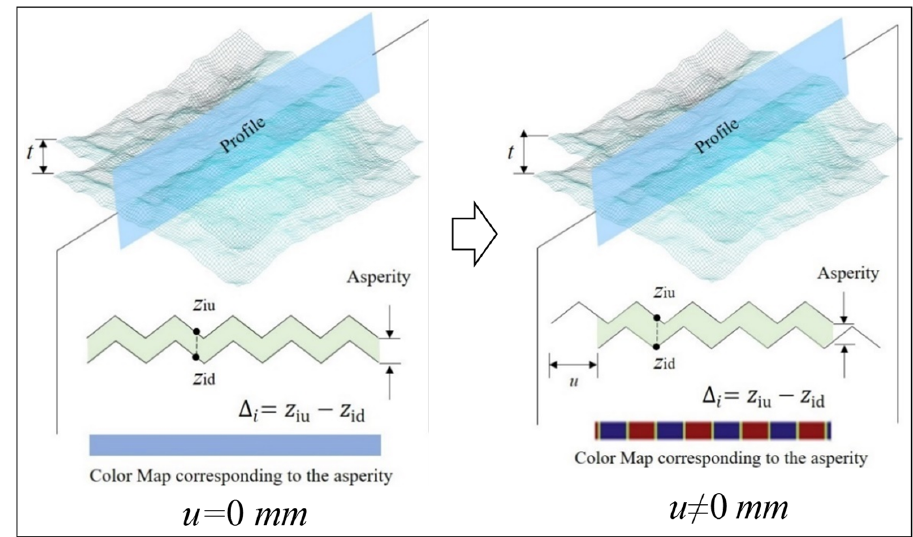
Figure 12. Schematic diagram of aperture.